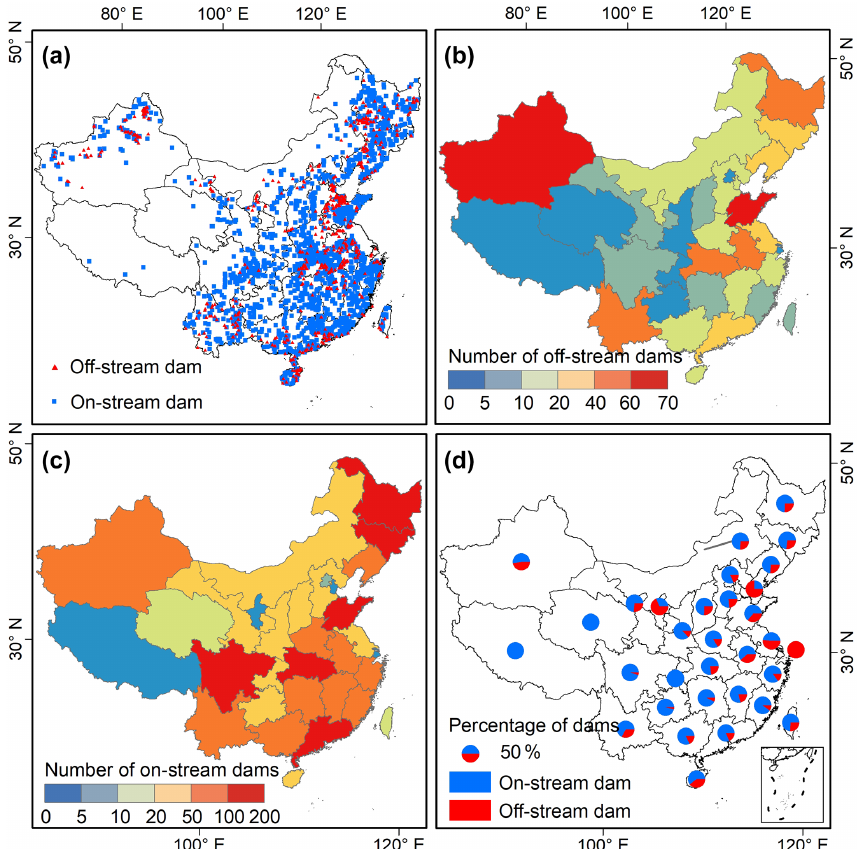
Figure 7. Distribution of off-stream and on-stream dams in China for 2019. (a) Spatial distribution of dams; (b) number of off-stream dams by province; (c) number of on-stream dams by province; and (d) percentage of off-stream and on-stream dams by